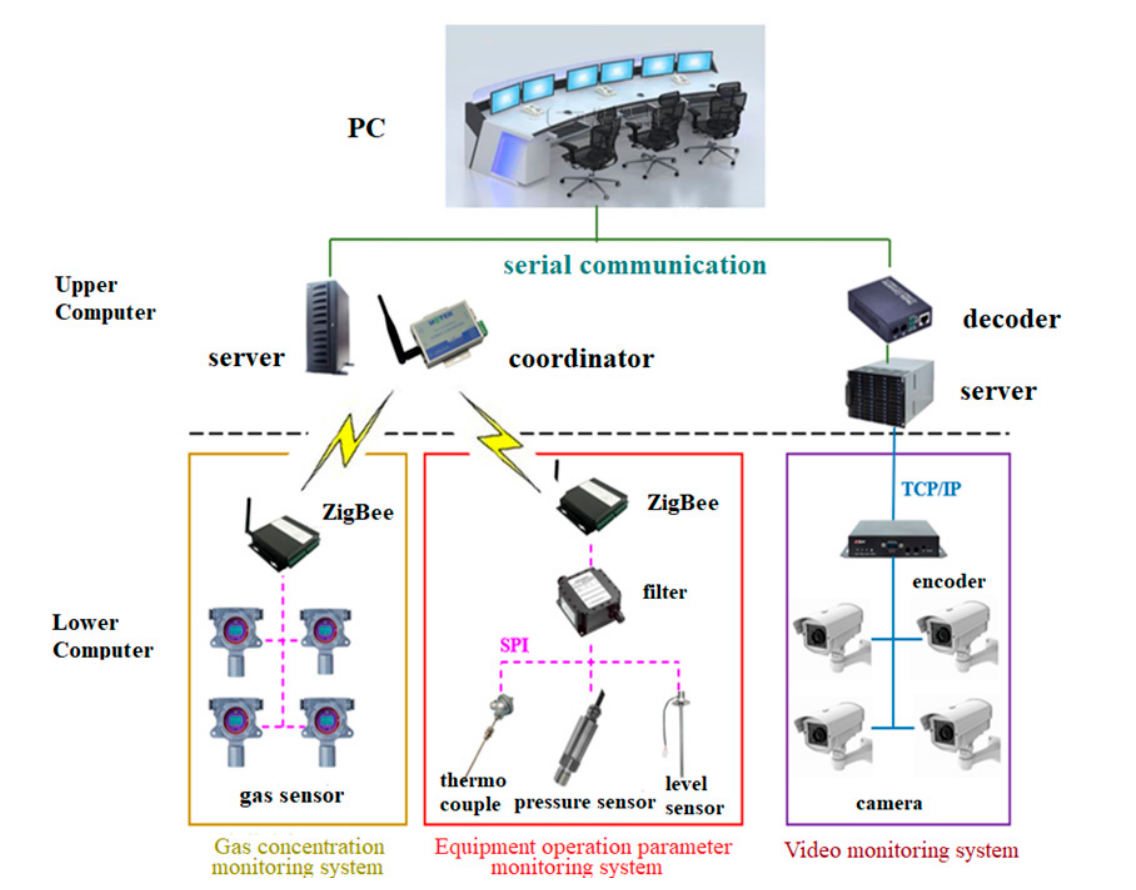
Figure 10. General framework of visual monitoring platform.